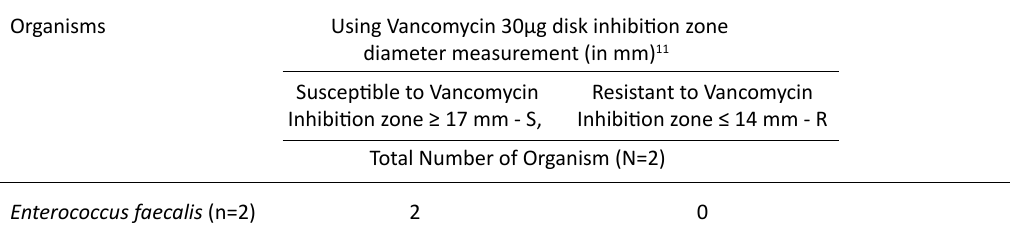
Table 2. Number of Vancomycin Sensitive Enterococcal species Organisms